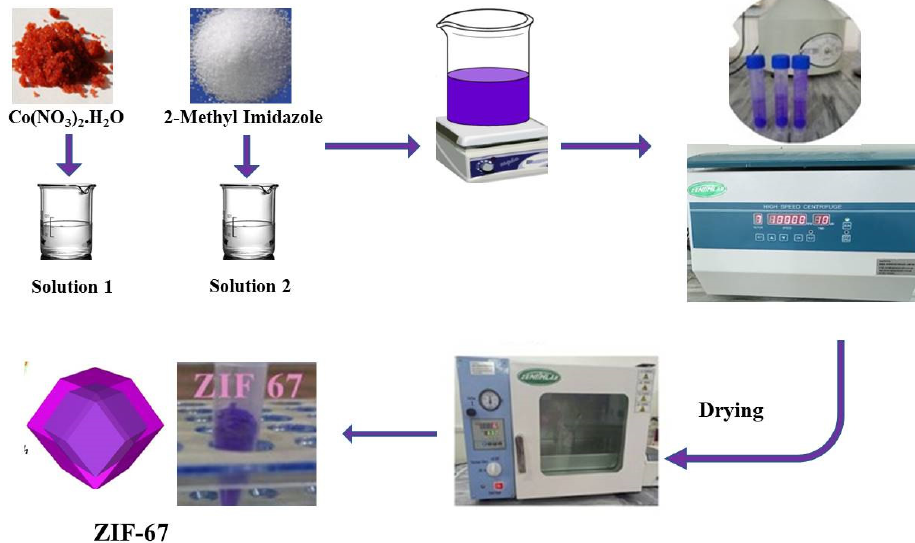
Scheme 1. Schematic diagram of synthesis of ZIF-67.